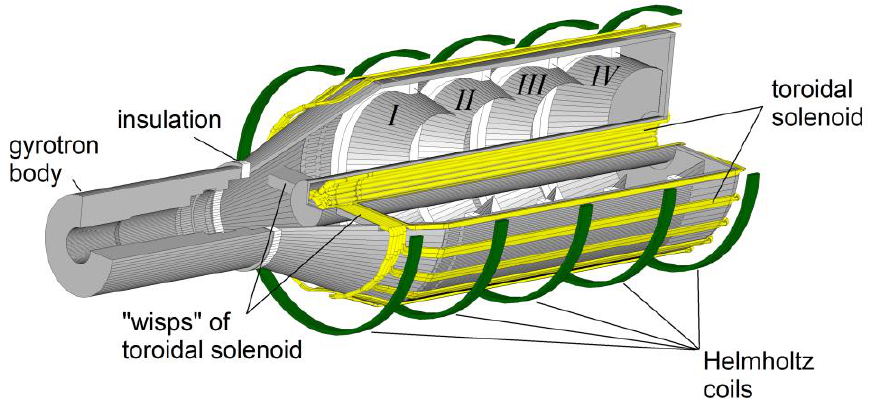
Fig. 3. Schematic drawing of the collector